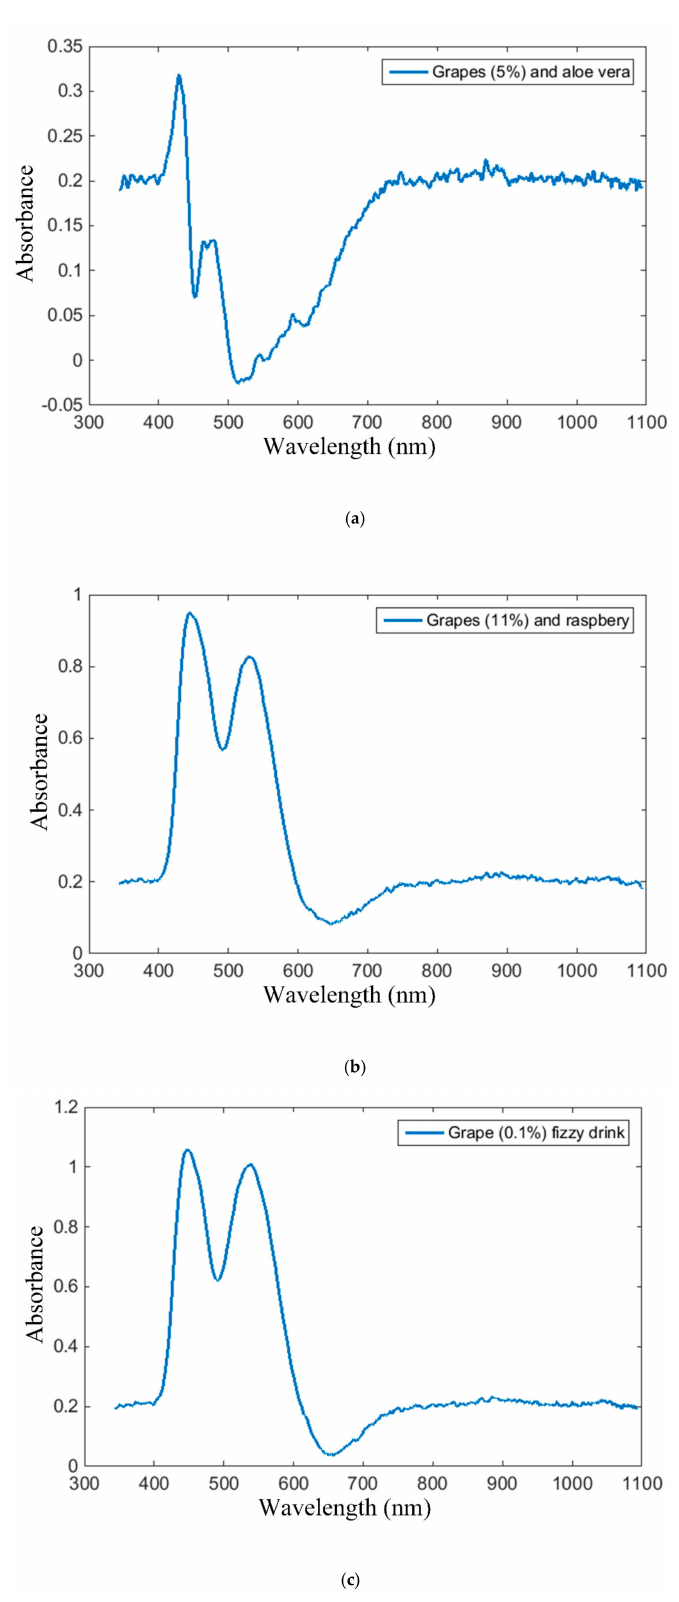
Figure 18. Grape-based drink absorption spectra, acquired via the proposed intra-oral point sensor: ( a ) white grape (5%) and aloe vera, ( b ) white grape (11%) and raspberry, and ( c ) red grape (0.1%) fizzy